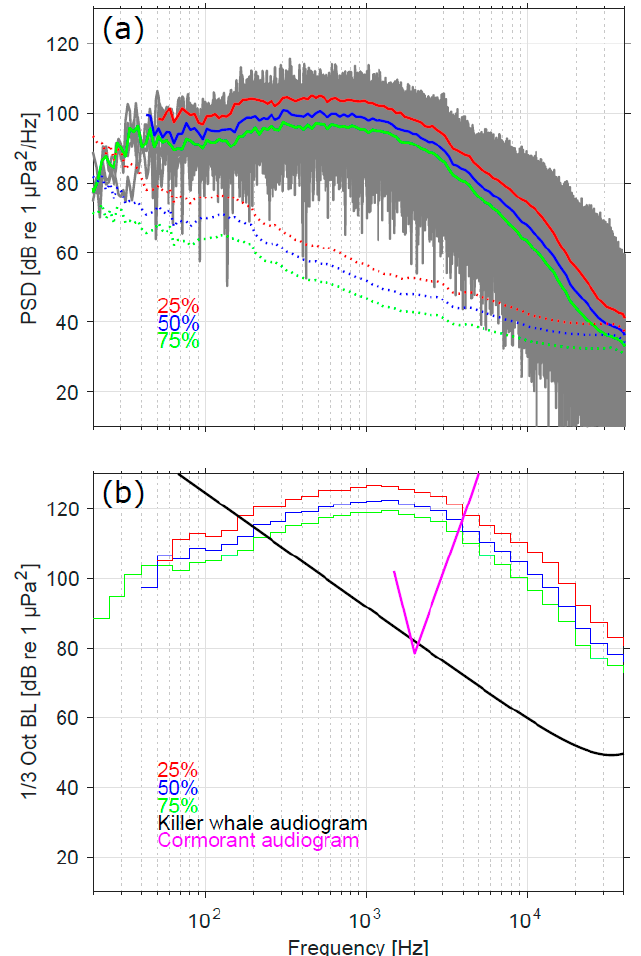
Figure 4. Underwater ( a ) received power spectral density (PSD) from 10 Growler overflights (grey), with median (blue) and quartile (red and green) levels. Ambient noise percentiles at the time of recording are shown in dotted curves. ( b ) One-third octave band levels (median and quartiles; blue, red, and green, respectively) shown together with the killer whale (black) and cormorant (pink) underwater audiograms. Noise above the audiogram lines is expected to be audible.